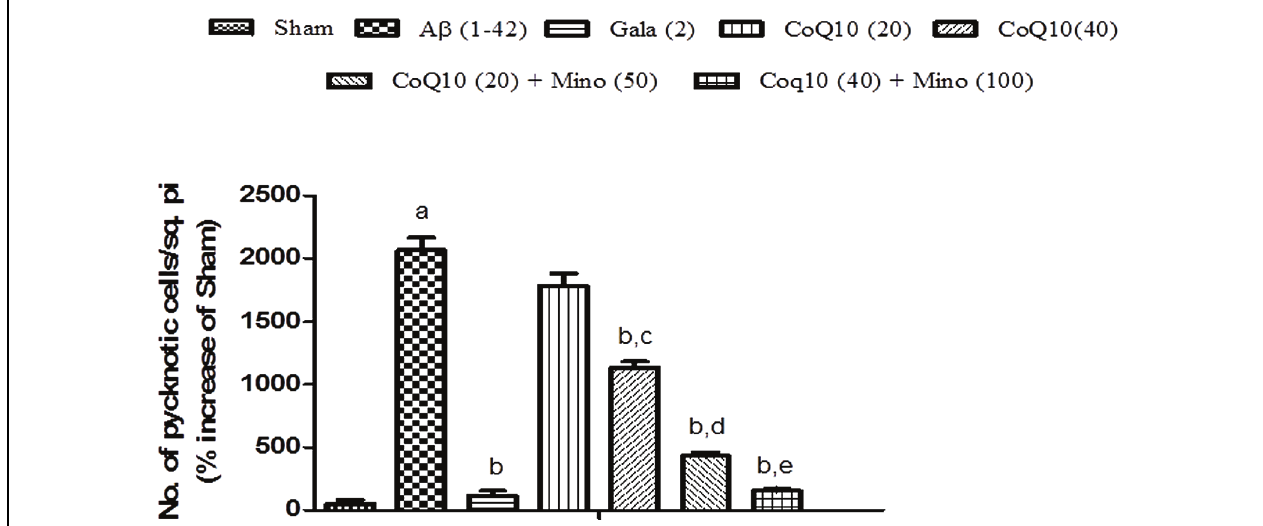
FIGURE 8 | Graph showing the effect of CoQ10 and Minocycline on pyknotic expressions per square pixel. Data expressed as mean ± SEM, a P < 0.05 compared to sham group, b P < 0.05 compared to A β (1-42) treated group, c P < 0.05 compared to CoQ10 (20) group, d P < 0.05 compared to CoQ10 (20) group and A β (1-42) treated group, e P < 0.05 compared to CoQ10 (40) and A β (1-42) treated group (One way ANOVA followed by Tukey’s test). (A β , Amyloid beta; Gala, Galantamine; CoQ10, Coenzyme Q 10; Mino, Minocycline).